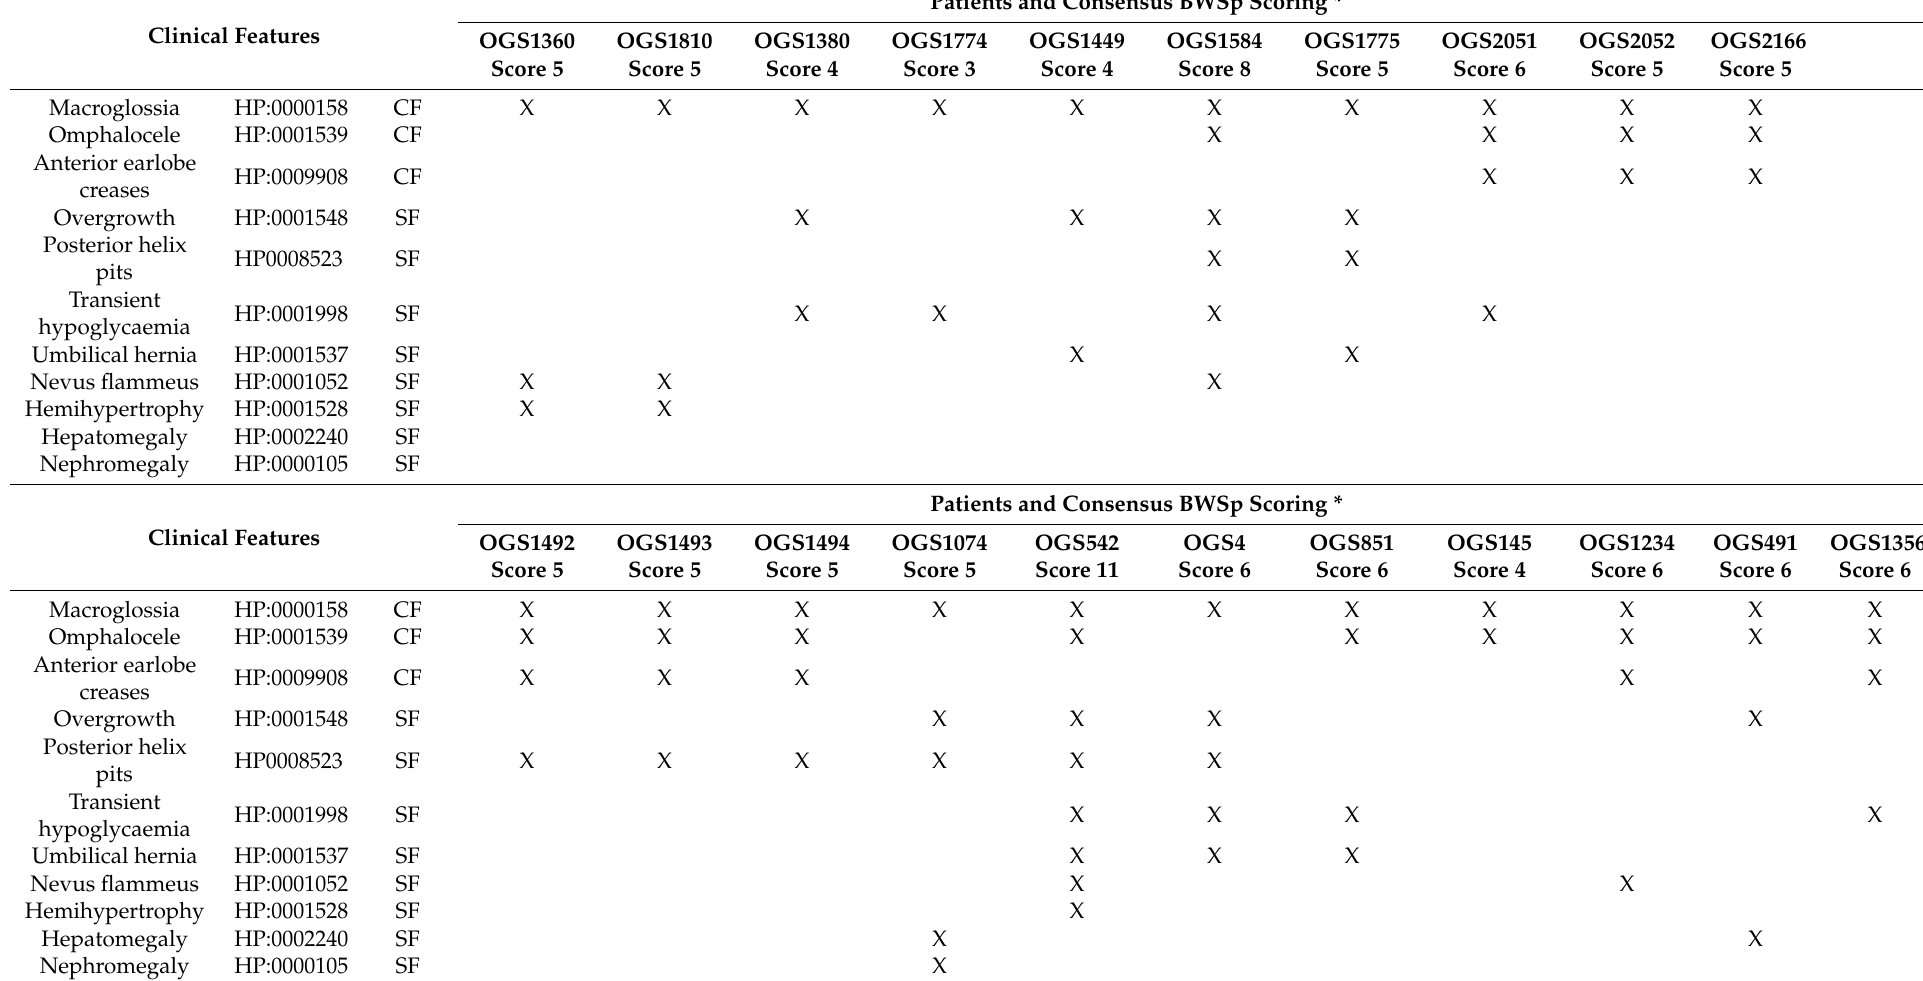
Table 3. BWSp consensus scoring in 21